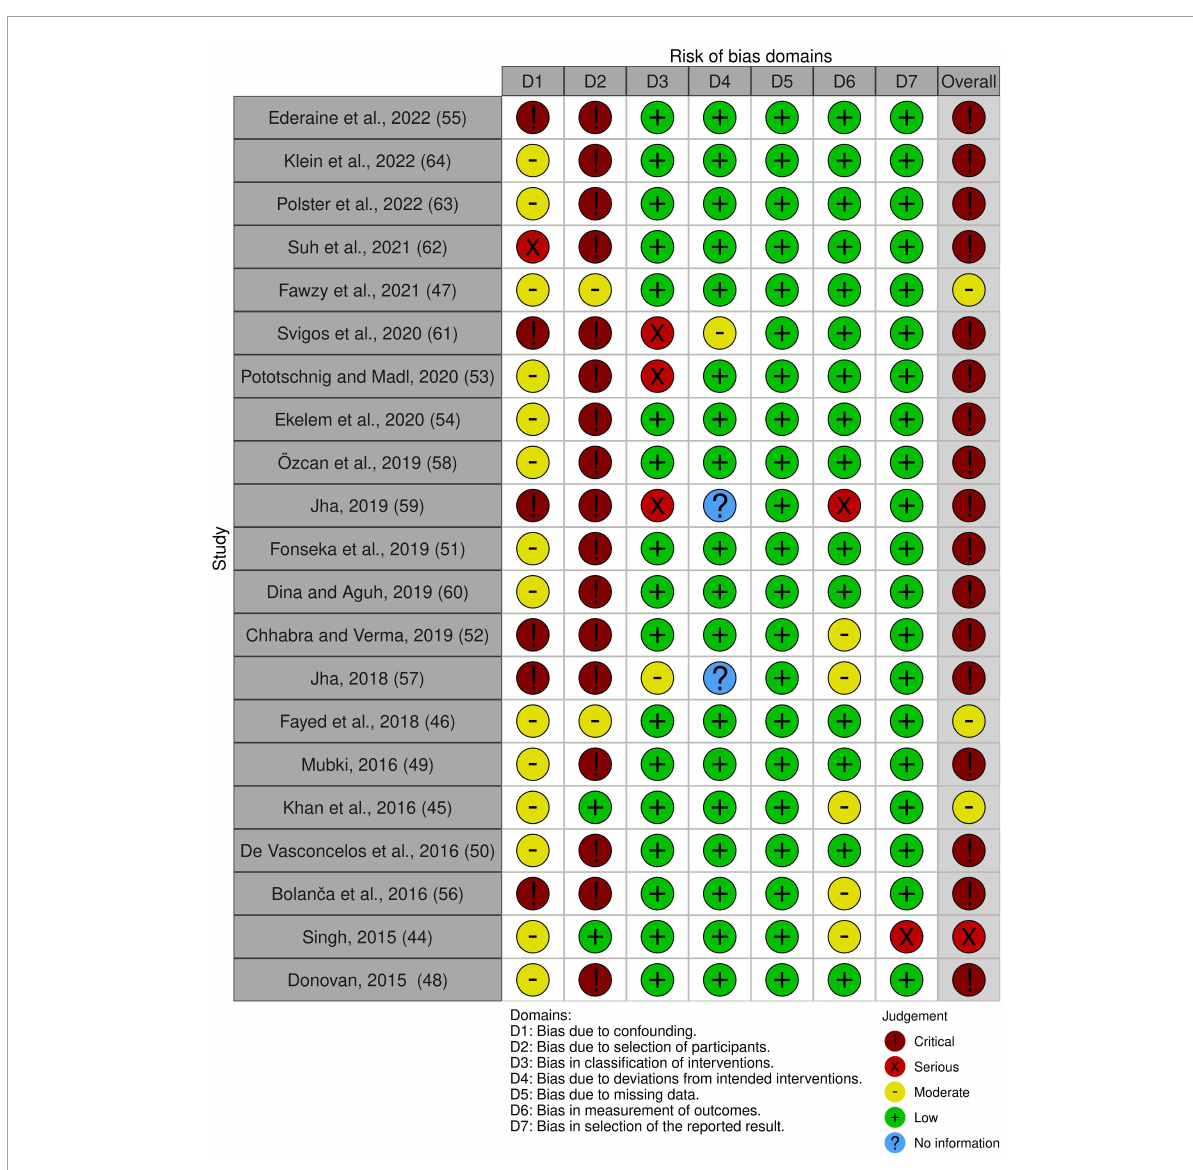
FIGURE3 Risk of bias of included randomized studies.